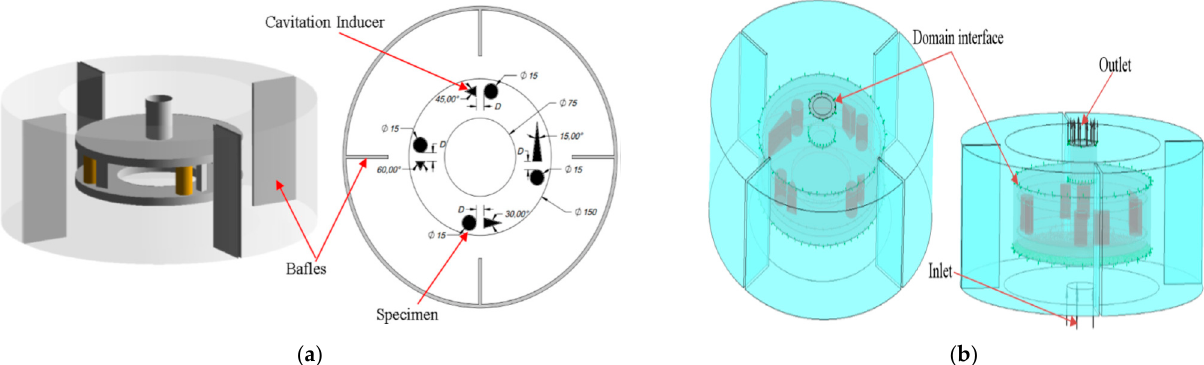
Figure 18. ( a ) Tribometer configuration, ( b ) boundary conditions: slurry pot tester cavitation and erosion simulation [46].